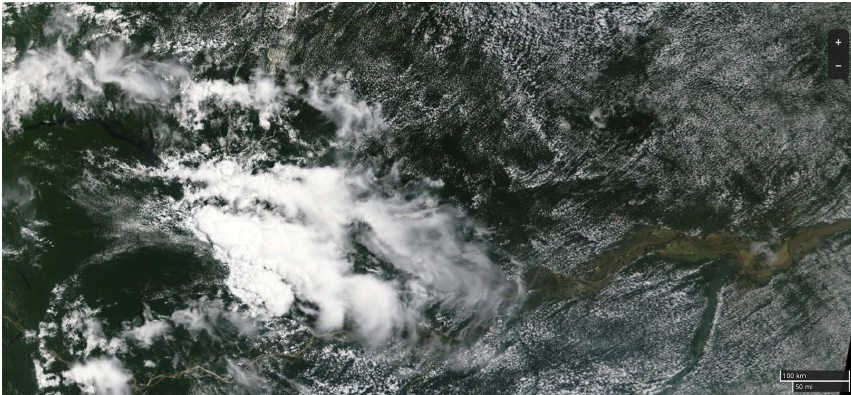
Figure 1. Snapshot of cloud cover over the Amazon Basin on 25 September 2018 (courtesy NASA Earth Observatory, MODIS visible bands). Small clouds are shallow convective clouds, highlighting surface Bowen ratio changes between the river and the forest. On the left, the deep convective cells do not follow the surface heterogeneity (and are much larger in scale). Note the cold-pool bow effect on the bottom left corner, with no clouds within the cold pools and clouds on the edge of the cold pool.